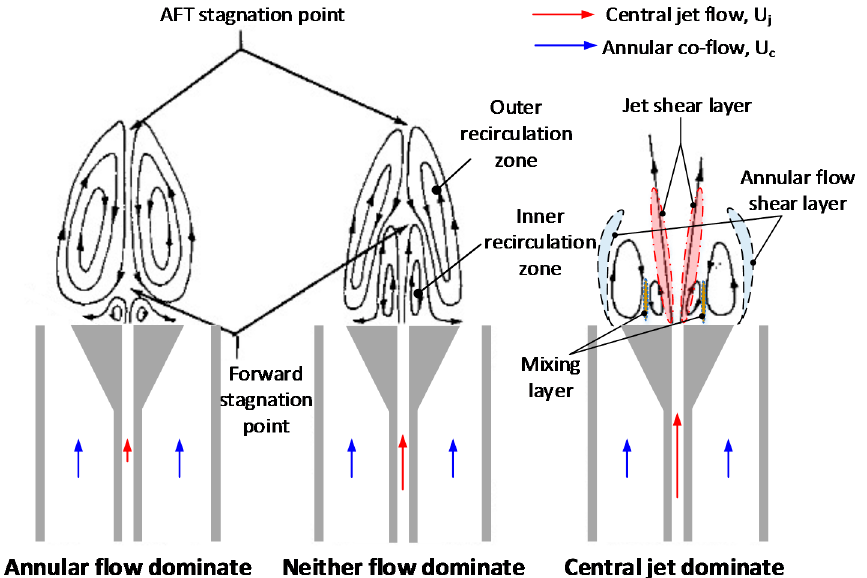
Figure 1. A schematic of time-averaged flow fields downstream of a bluff-body with a central jet (reproduced from [19]).